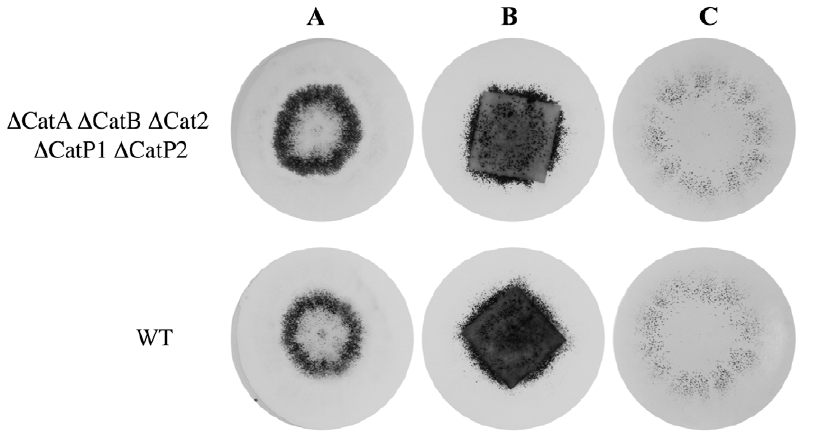
Figure 3. Phenotypes of wild type and the catalase quintuple mutant on medium with cellulose. Self-fertile mycelia of the strain devoid of catalase ( D CatA D CatB D Cat2 D CatP1 D CatP2) and of the wild-type strain (WT) were inoculated at the center of the plate on medium with ( A ) dextrins as sole carbon source, ( B ) on 3 cm 6 3 cm filter papers as sole carbon source, and ( C ) on medium with cellulose powder as sole carbon source. On the 3 media, after seven days of growth, WT, and the catalase mutants had differentiated numerous fructifications (the small black dots) mostly in a region surrounding the explant and no difference was observed between WT and the mutant.